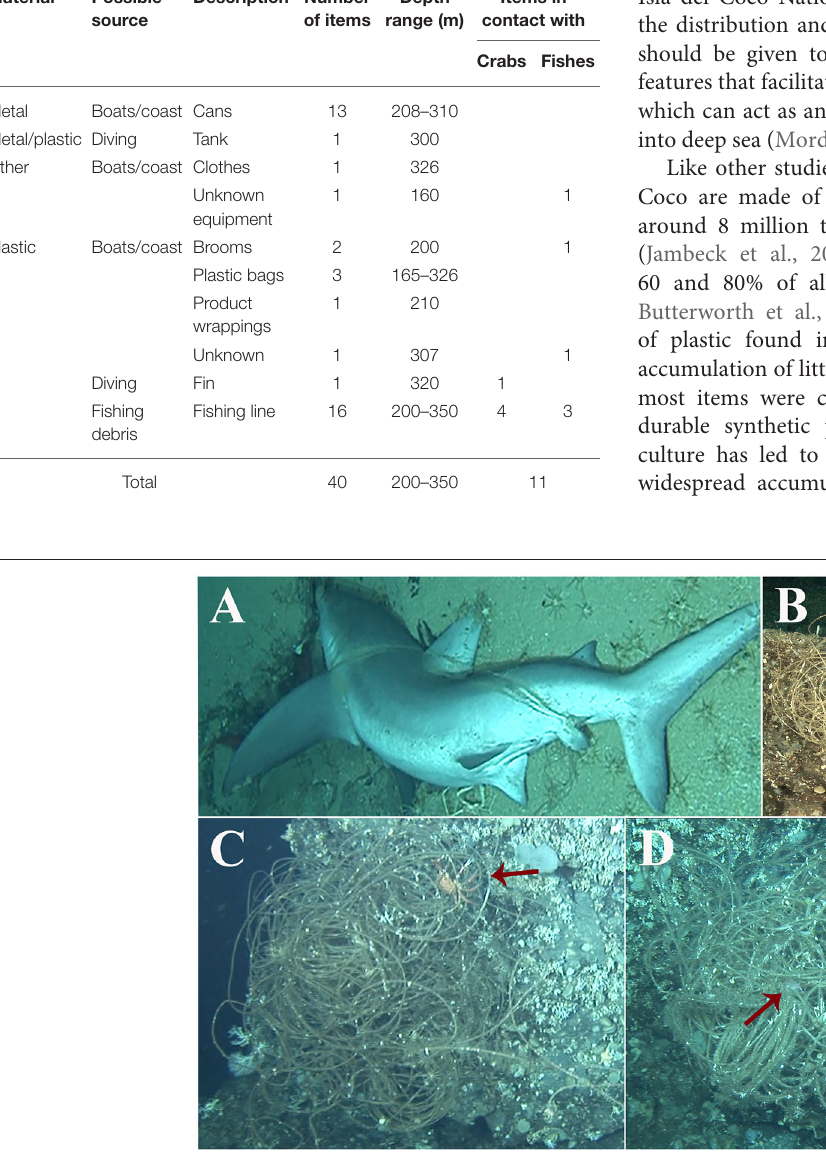
FIGURE 2 | Abandoned, lost or discarded fishing gear deposited in deep environments of Isla del Coco National Park. (A) Silky shark ( Carcharhinus falciformis ) attached to a line at 200 m depth. (B) A crab presumably scraping food from the fishing line, 302 m depth. (C) A tangled crab (red arrow) in a fishing line, 320 m depth. (D) A serranid (Anthiinae; red arrow) looking for food or refuge inside a fishing line, 350m depth.